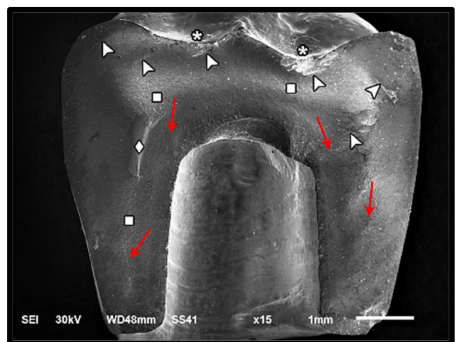
Figure 10. SEM micrograph represents class III failure mode of zirconia fractured specimen showing fracture origins (asterisk) at the loading occlusal surface of the restoration (two origins), hackle lines (square) indicating the direction of crack propagation from occlusal to cervical (red arrow), compression curl (diamond), and diffused arrest lines